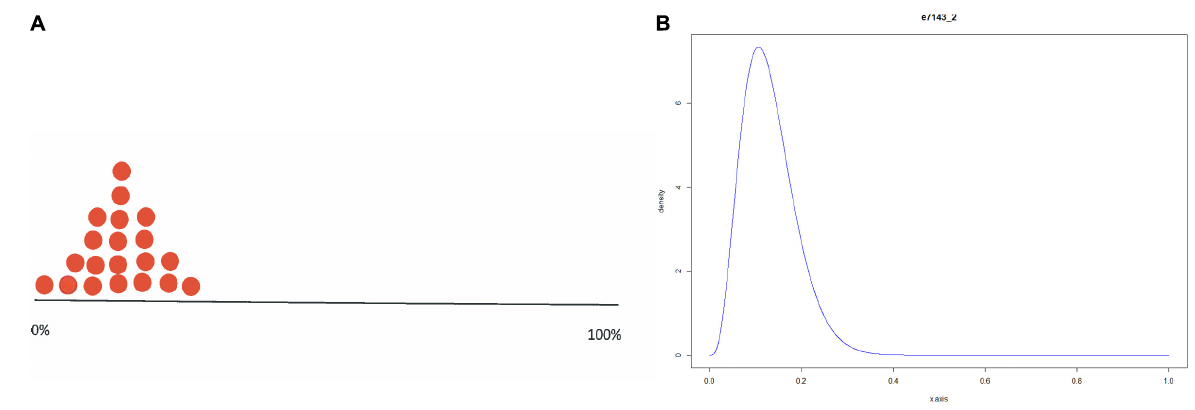
Frontiers in Psychology |